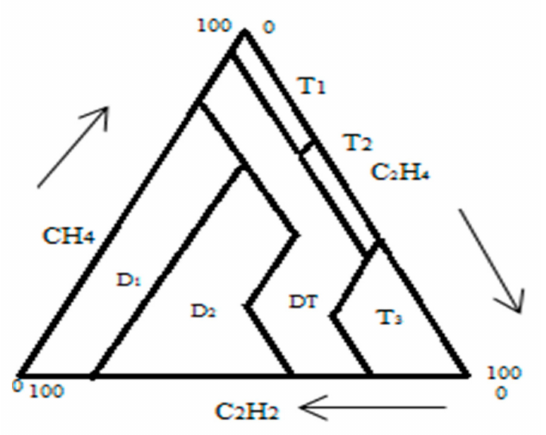
Figure 1. Description of Duval